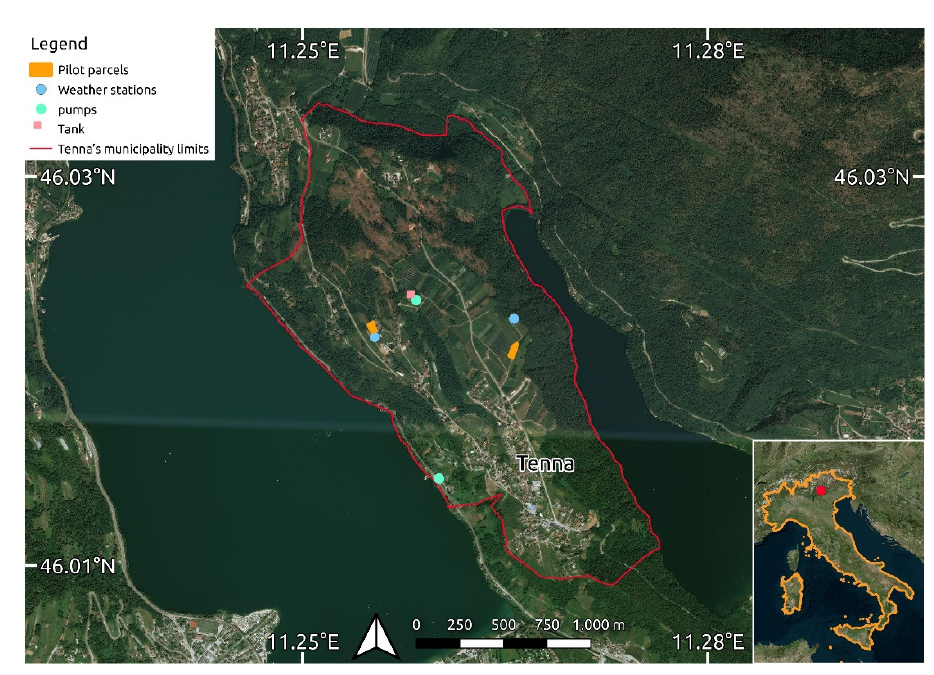
Table 2. Average monthly temperatures (i.e., minimum and maximum) of 2019 (Source: 3bmeteo). Jan Feb Mar Apr May Min T ( ◦ C) − 0.6